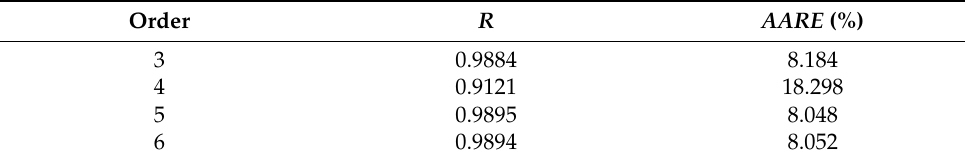
Figure 7 is a scatter diagram composed of experimental stress and calculated